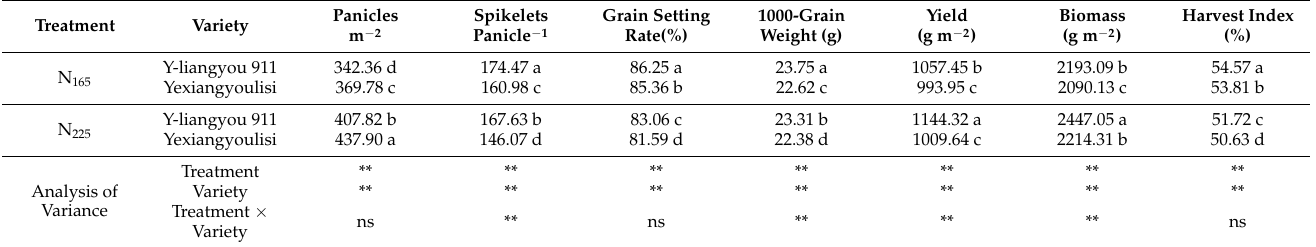
Table 4. Effects of N application rates on yield and yield components in high-quality rice